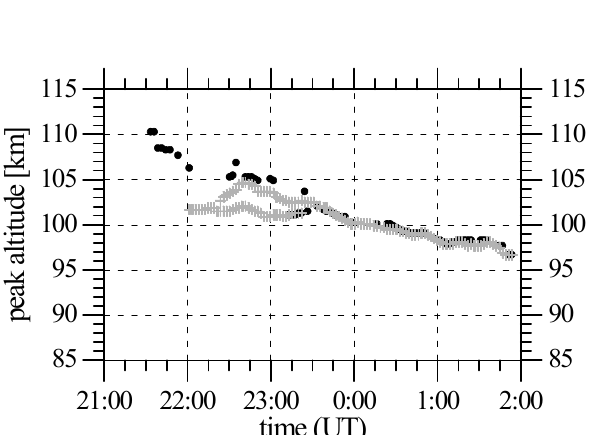
Fig. 3. Series of density profiles ob- tained during the night August 1/2, 1997 for Ca + (upper panel) and Ca (lower panel). Note the very different density scales for the ionized and neu- tral Ca profiles.